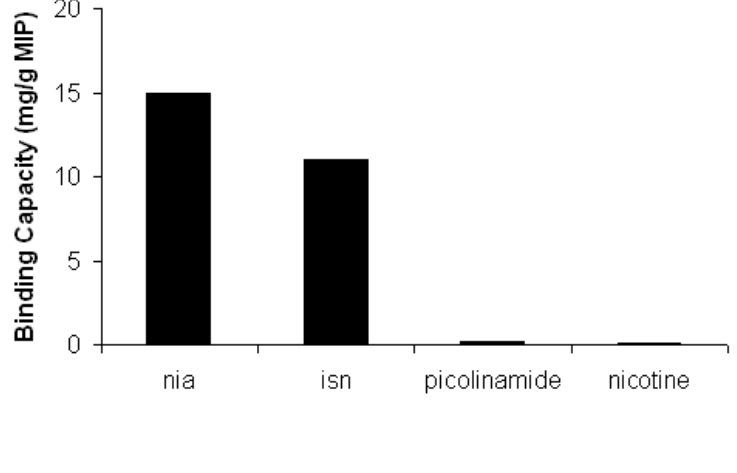
Figure 7. Binding capacity of imprinted polymer P1 versus different nitrogen